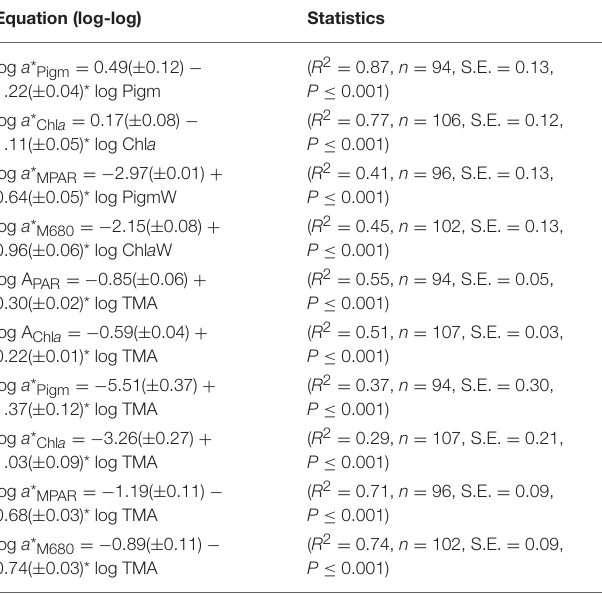
TABLE 2 | Equations derived from Least Squares (LS) regression analysis of log-log transformed data, describing the variation of the optical descriptors as a function of changes in the structural traits of the three coralline algae characterized in this study: the rhodolith Neogoniolithon sp., the articulated alga Amphiroa tribulus, and the crustose coralline algae (CCA) Lithothamnion